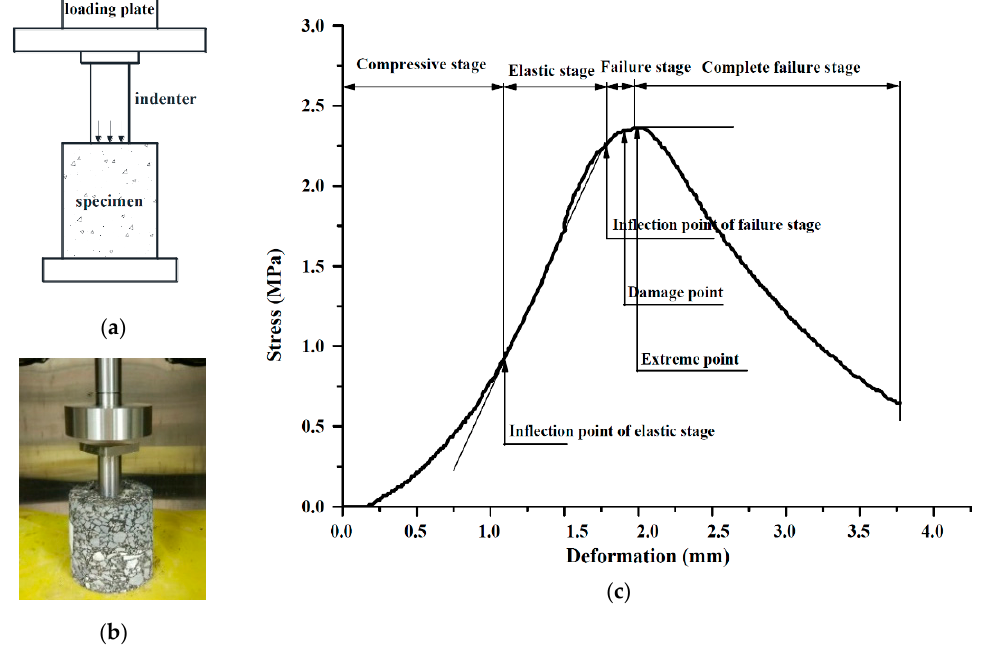
Figure 6. The loading mode, apparatus, and typical stress–deformation relationship of the UPT. ( a ) Loading mode of UPT; ( b ) An apparatus for UPT; ( c ) A typical stress–deformation relationship in the test.